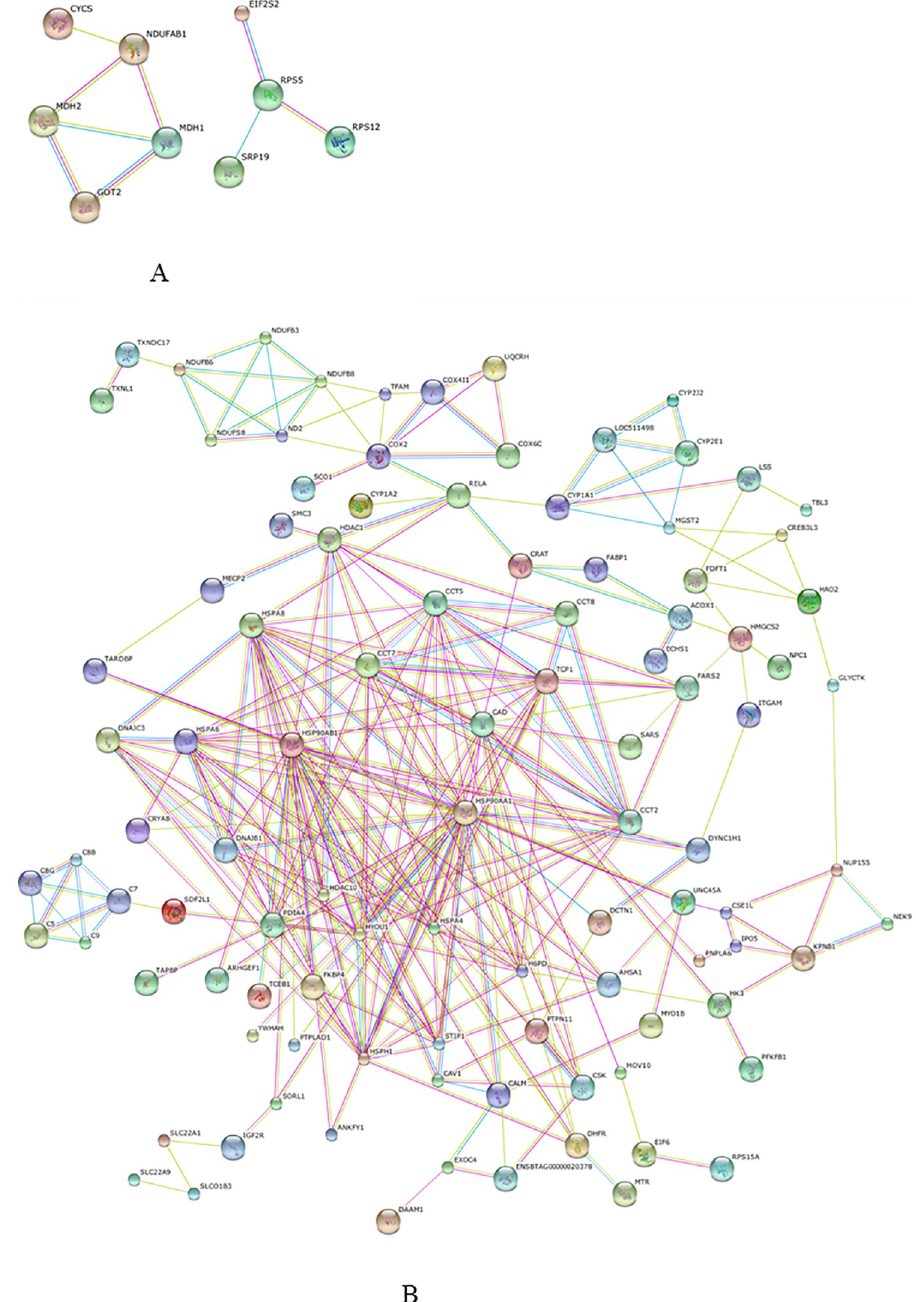
Fig 4. Protein interaction network of the differential proteins from mammary gland (A) and liver (B) predicted with STRING software. Each node presents a protein; line colors present the types of evidence: pink lines from experimental study, the blue lines from databases, and the yellow lines from abstracts of articles published in